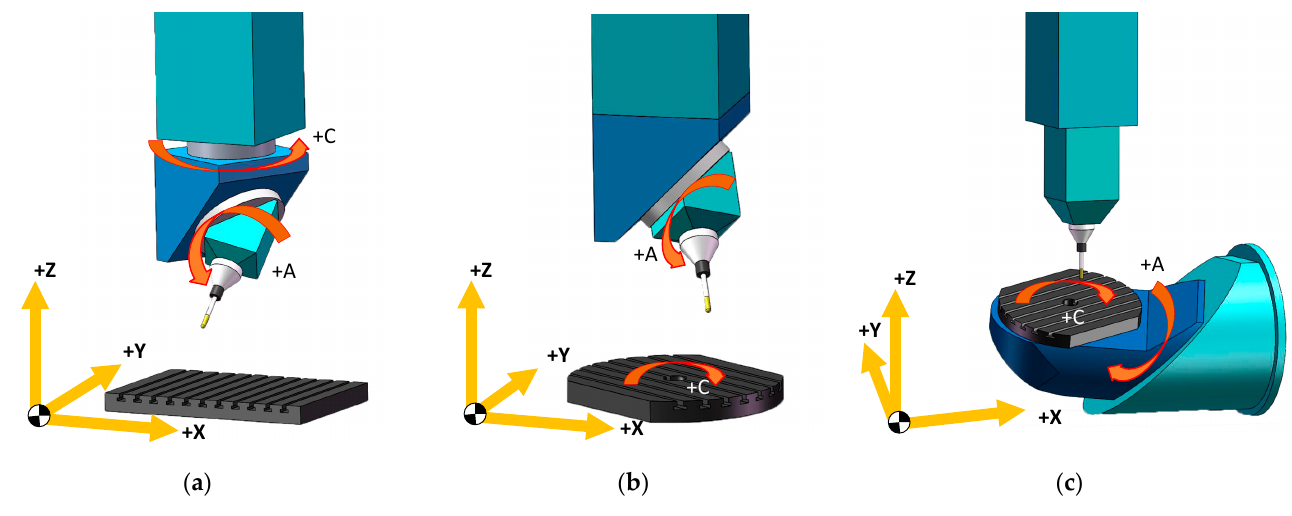
Figure 2. Common structure layouts of machine tools with pendulous rotary axes. ( a ) Dual-head style, ( b ) single-head and single-turntable style, ( c ) dual-turntable style. style, ( b ) single-head and single-turntable style, ( c ) dual-turntable